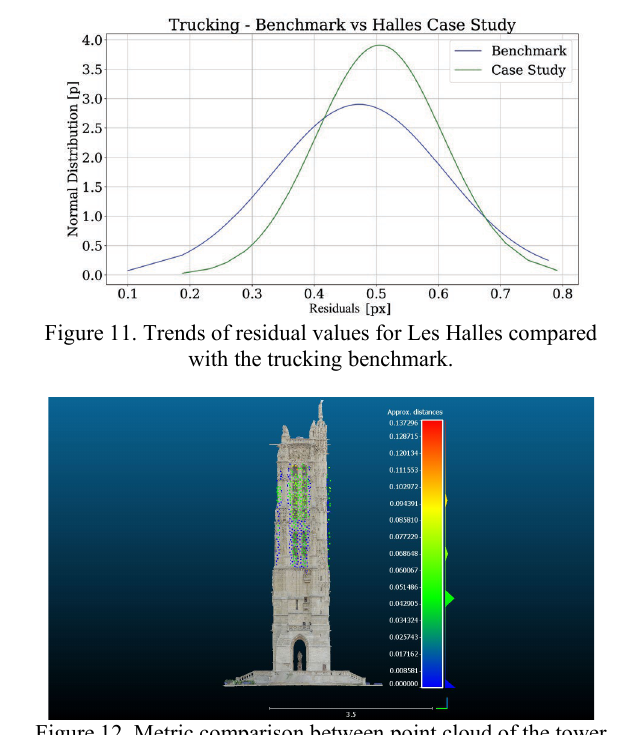
Figure 10. Trends of residual values for the Tour Saint Jacques compared with the tilting benchmark.